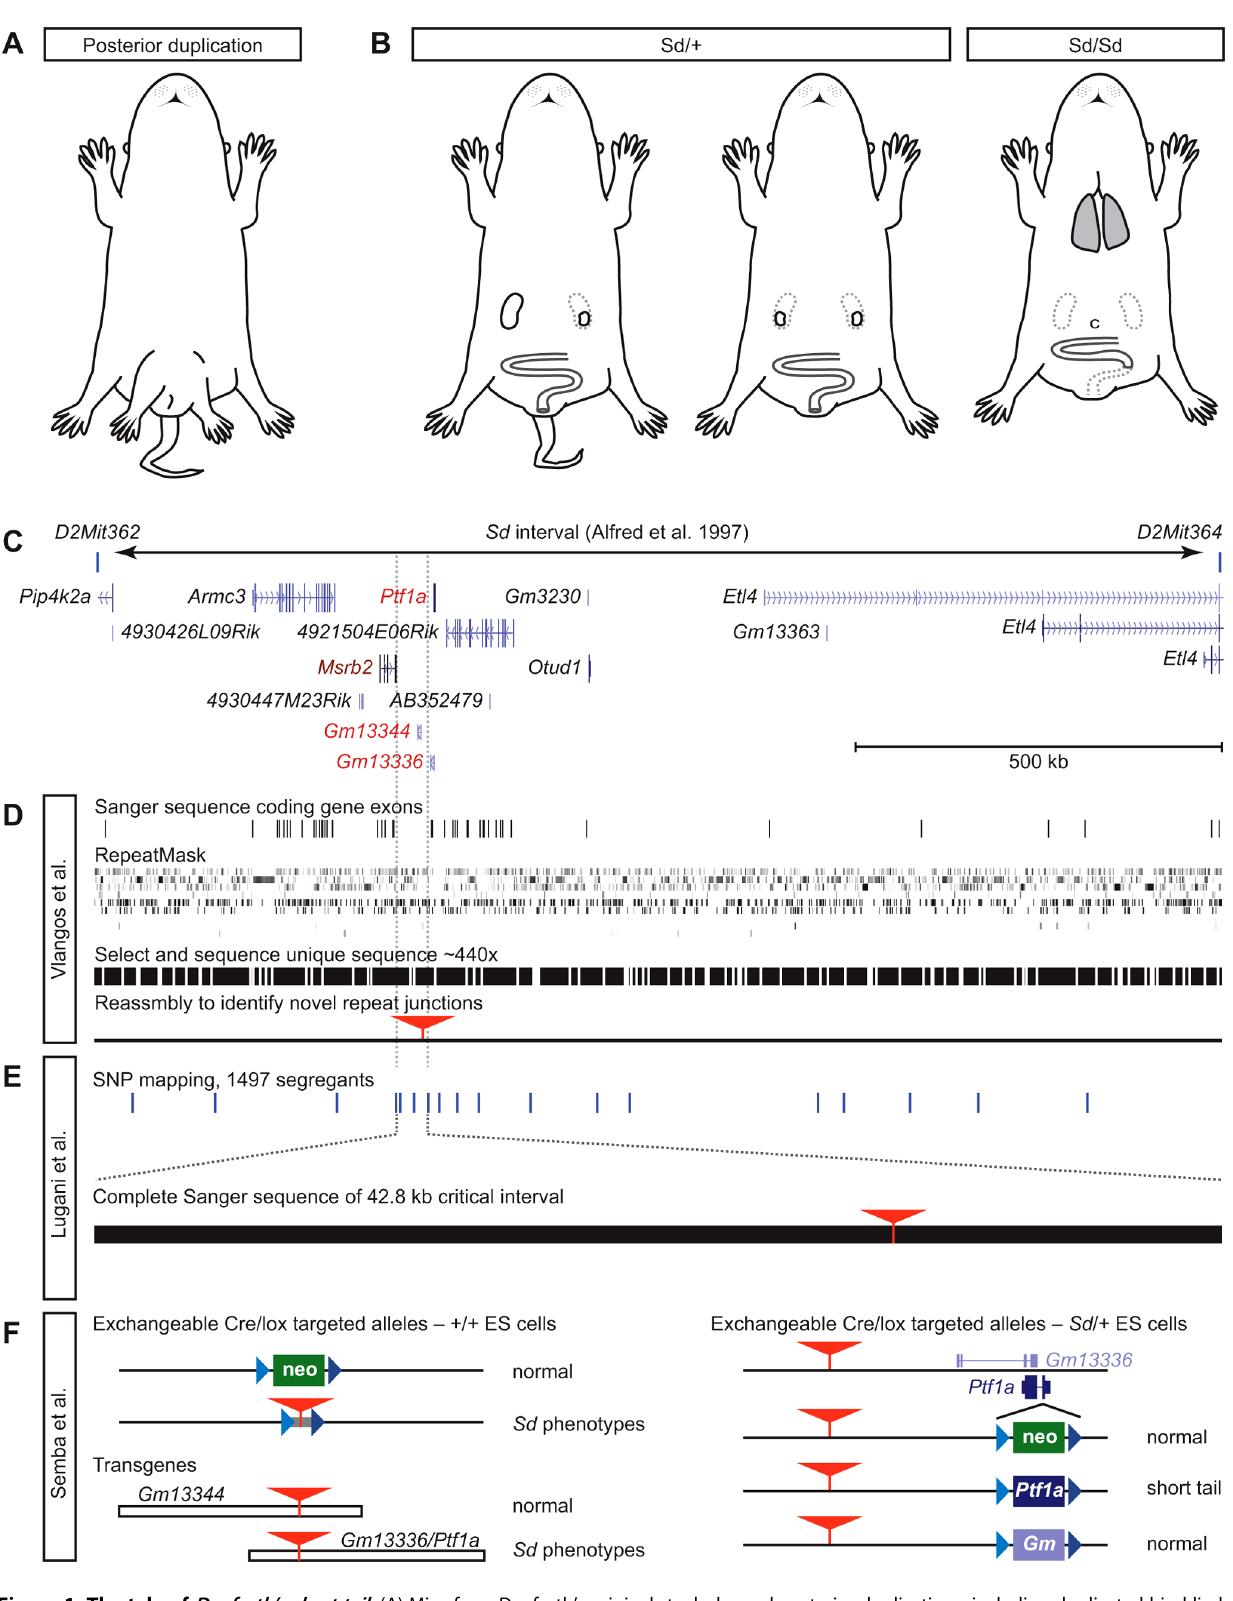
Figure 1. The tale of Danforth’sshorttail . (A) Mice from Danforth’s original stock showed posterior duplications, including duplicated hind limbs and a pelvic bulge, in addition to kinked and sometimes shortened tails. Drawing idealized from photographs in [2]. (B) Sd / + mice show a strain- dependent range of caudal phenotypes, including kinked, shortened, or absent tail and reduction or loss of one kidney, but without pattern duplications. Sd / Sd animals die at birth with caudal regression, including malformation of vertebrae, absent tail, loss of both kidneys, persistent cloaca